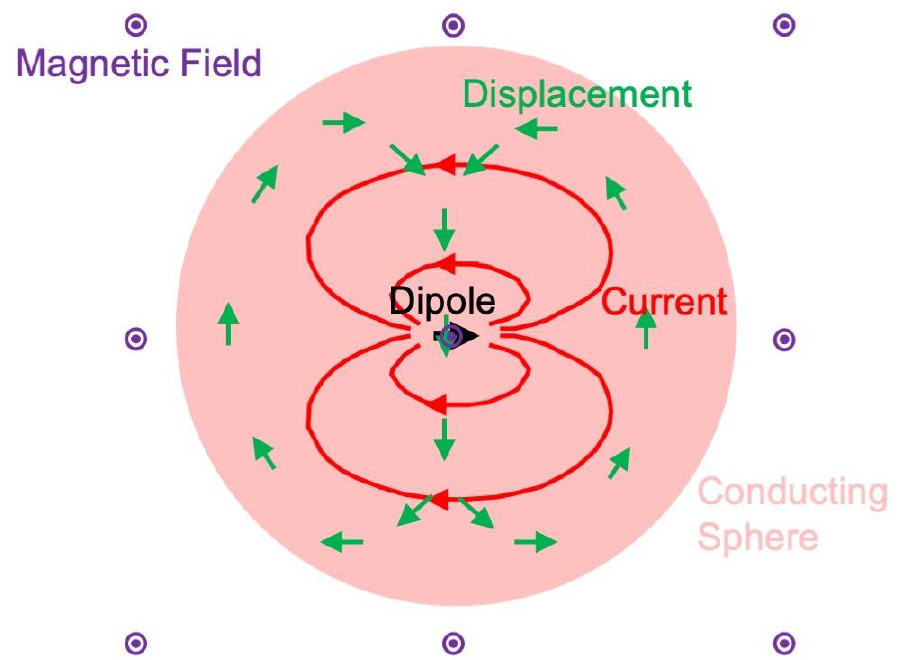
Figure 2. The current and displacement produced by a dipole in a conducting sphere.